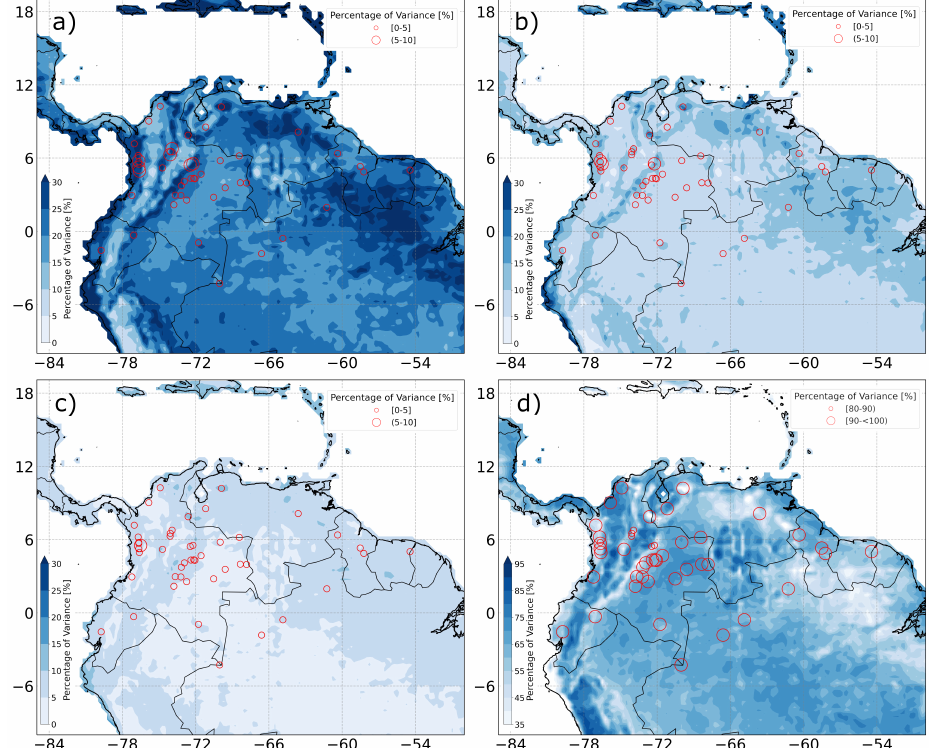
Figure 5. Percentage of the total variance explained by the synoptic modes of variability for daily precipitation over the region of study, and streamflows of each catchment (red circles). ( a ) IMF 1; ( b ) IMF 2; ( c ) IMF 3; ( d ) variance explained by the other frequency